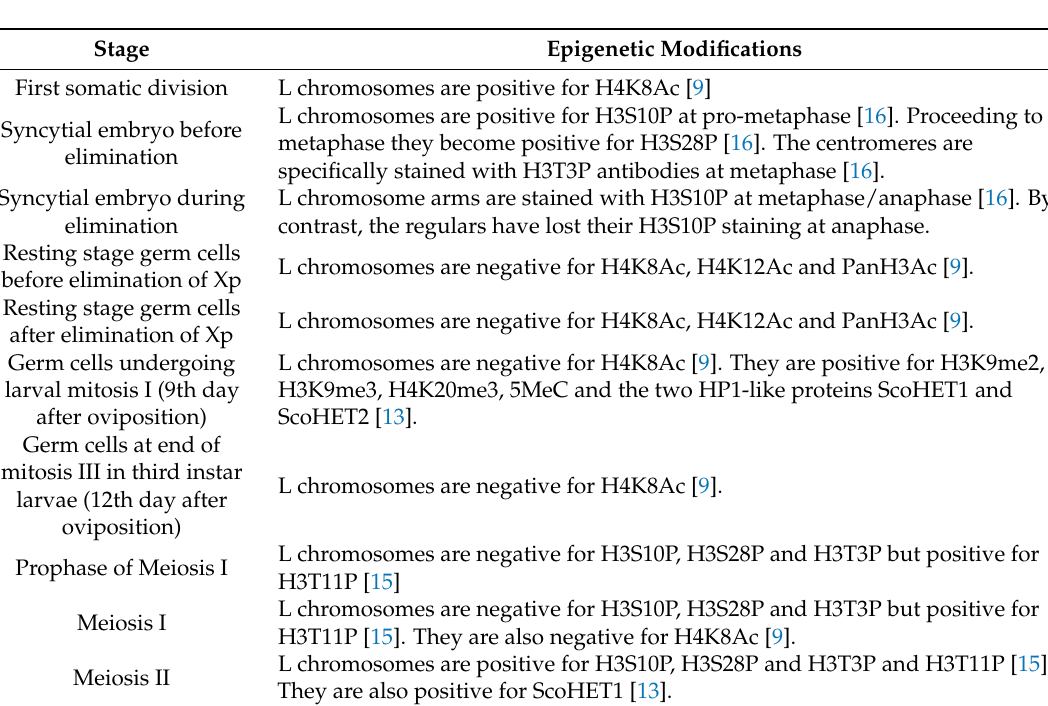
Table 1. Epigenetic modifications associated with the supernumerary L chromosomes at different stages of development. L chromosomes have epigenetic profile characteristic of constitutive heterochromatin. Apart from the first somatic mitosis, the L chromosomes are de-acetylated. Where investigated, L chromosomes also share the repressive epigenetic modifications and non-histone heterochromatin protein 1 (HP1) chromosomal proteins. Analyses of phosphorylation show that during the somatic eliminations the arms of the L chromosomes retain phosphorylation with H3S10P. During meiosis